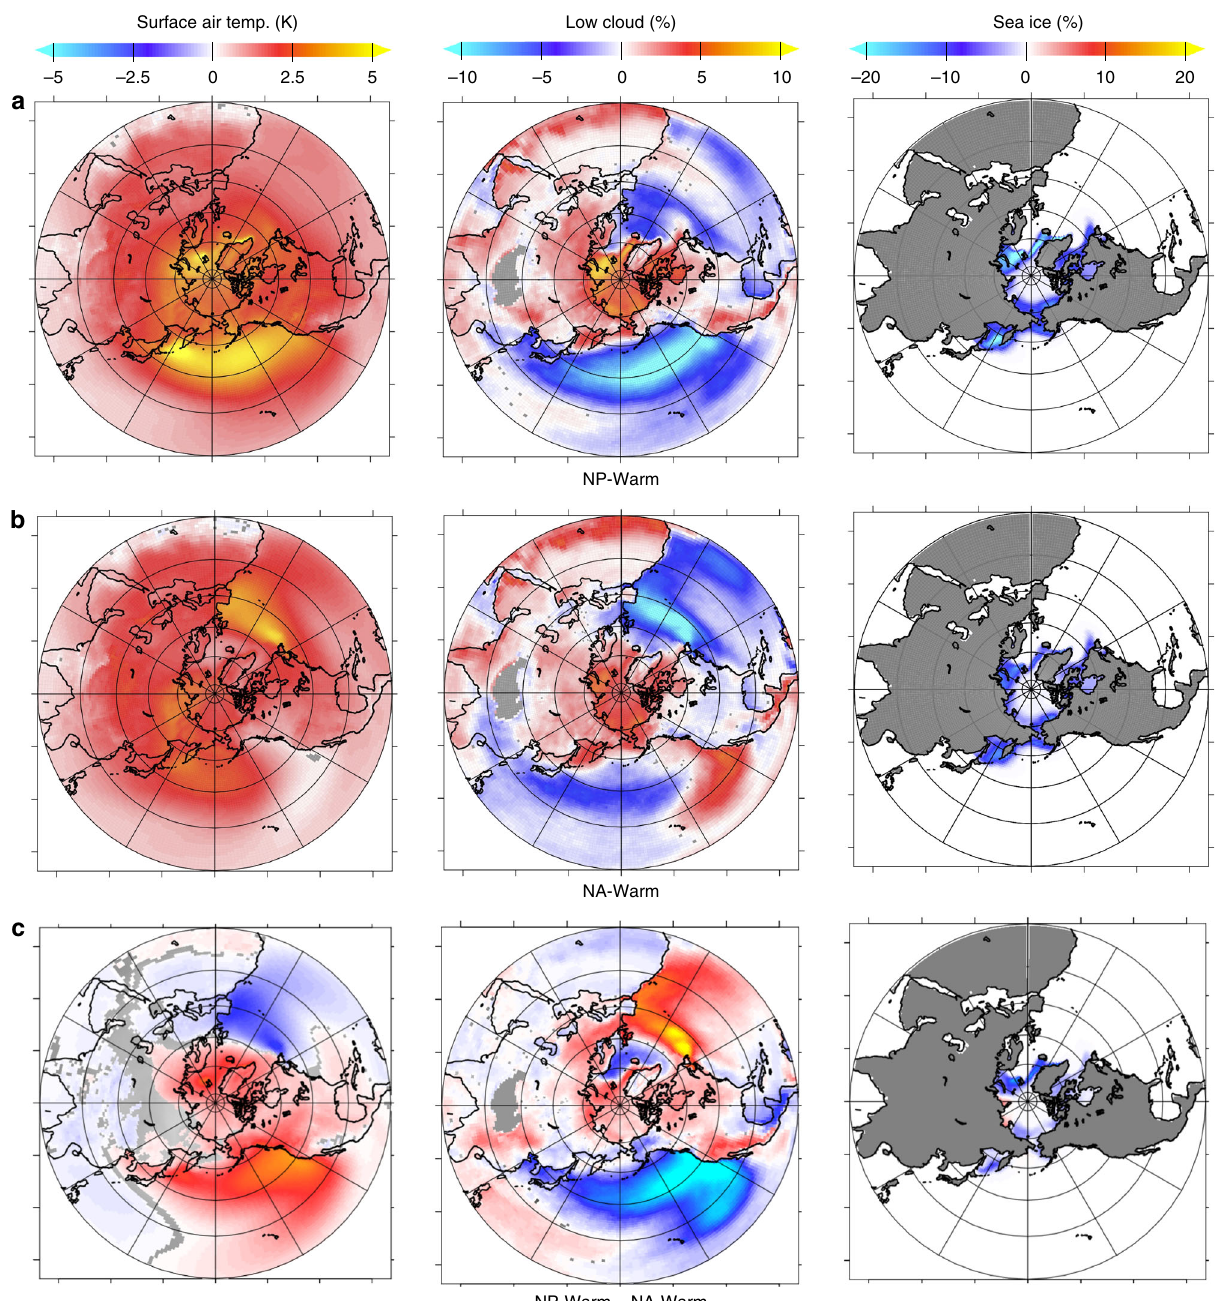
Fig. 3 Surface air temperature, vertically integrated low cloud, and sea-ice anomalies in the warm ocean simulations. Simulations for a warm North Paci fi c (NP-Warm), b simulations for a warm North Atlantic (NA-Warm), and c the difference of the two simulations (NP-Warm − NA-Warm). Gray areas indicate changes not signi fi cant at the 95% con fi dence